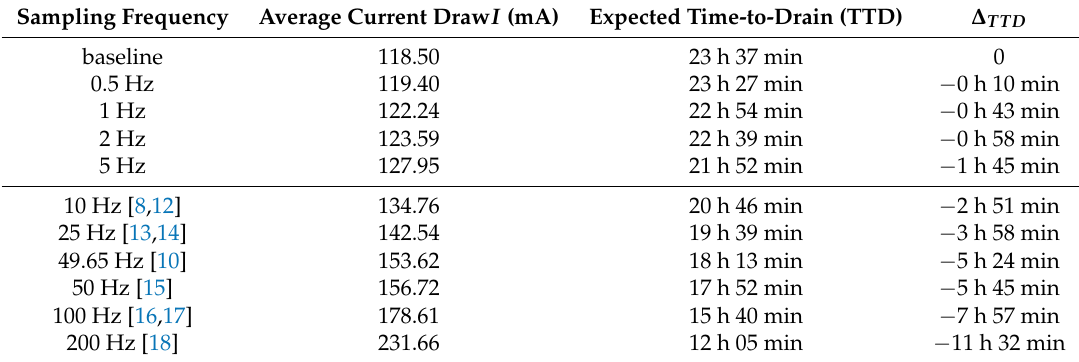
Table 1. Energy consumption due to magnetometer sensing at various frequencies on Galaxy S5. Sampling